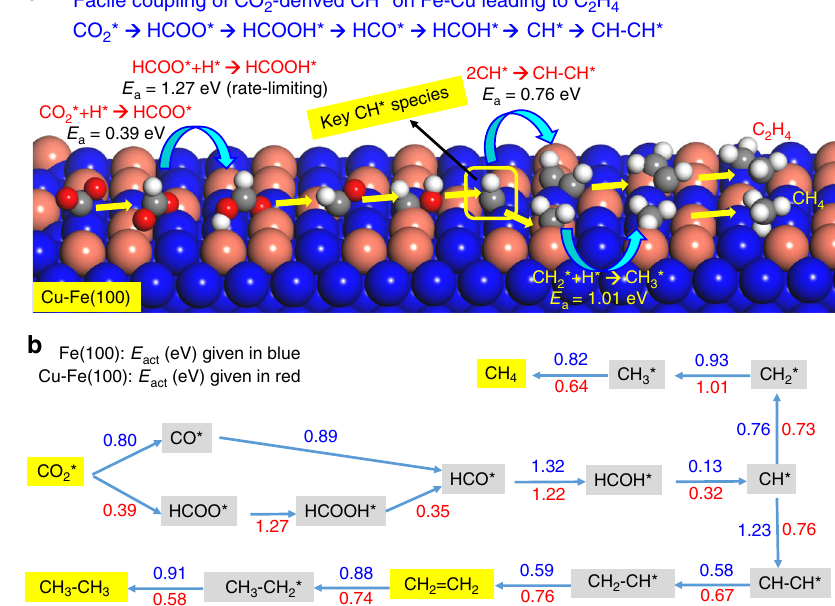
Fig. 3 Mechanistic insight into C – C coupling over Fe-Cu bimetallic catalysts. a Mechanism of CO 2 hydrogenation to C 2 H 4 over a Cu – Fe(100) surface. b Reaction pathways for production of CH 4 , C 2 H 4 , and C 2 H 6 from CO 2 hydrogenation on Fe(100) and Cu – Fe(100) surfaces at 4/9 monolayer coverage. The kinetic barrier for each elementary step is given in eV. (Reprinted with permission from Nie et al. 108 . Copyright (2017) American Chemical